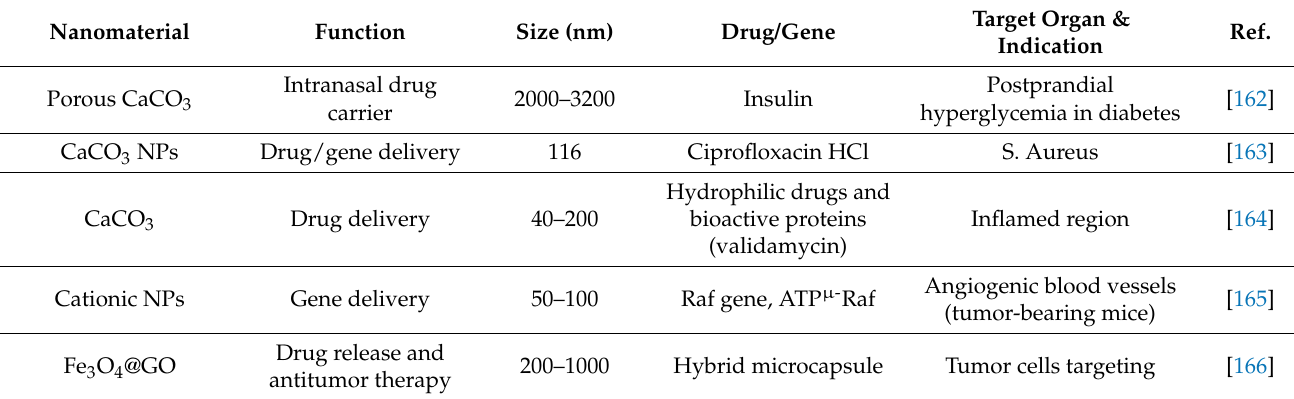
Table 2. Functionalized nanomaterials used for drug/gene